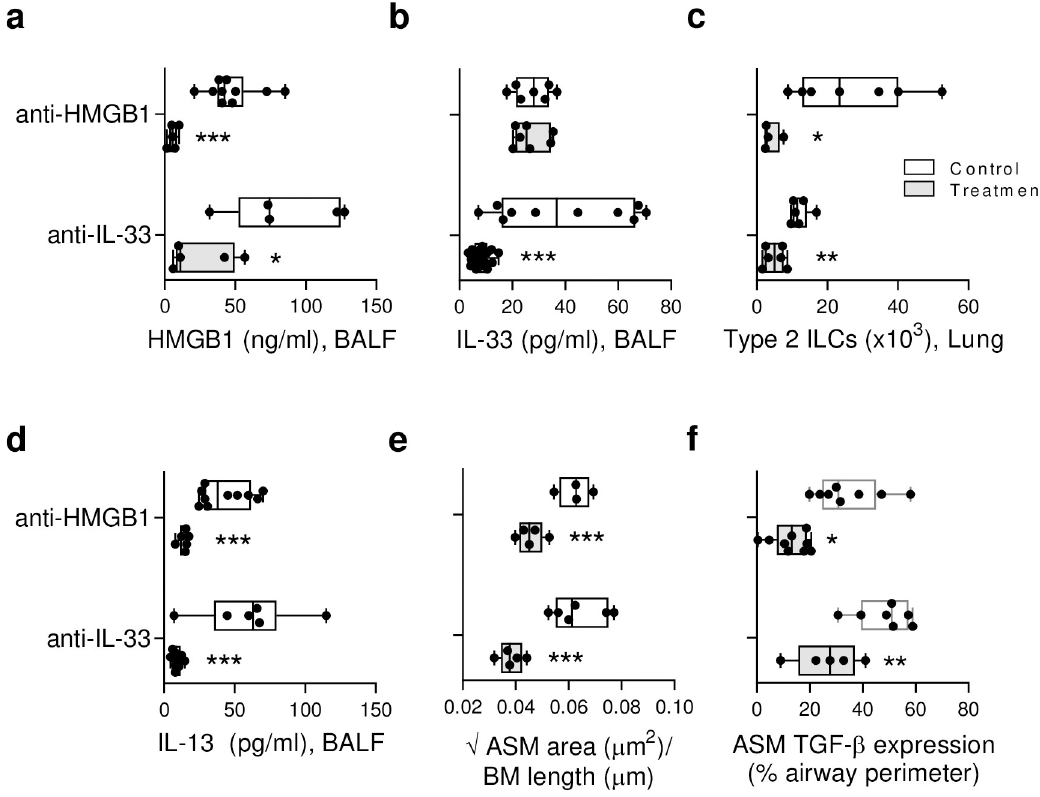
Fig 4. Anti-HMGB1 diminishes type-2 inflammation and ASM growth in neonatal IRF7 -/- mice. IRF7 -/- mice were inoculated with PVM as described in Fig 2, and treated with anti-HMGB1 or anti-IL-33 as described in S3 Fig. (a) HMGB1 and (b) IL-33 protein expression in BALF. (c) ILC2 numbers in lung. (d) IL-13 protein expression in BALF. (e) ASM area. (f) TGF- β 1 expression by ASM cells. Data are representative of n = 2 experiments with 4–8 mice in each group and are presented as box-and-whisker plots showing quartiles (boxes) and range (whiskers). Data were analysed by t-test; � , P < 0.05; �� , P < 0.01; ��� , P < 0.001.